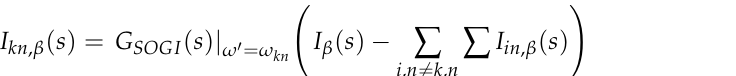
L9 Figure 4. Network graph with protection zones indicated by different colors: blue (zone 1), green (zone 2), yellow (zone 3), orange (zone 4), and red (zone 5).